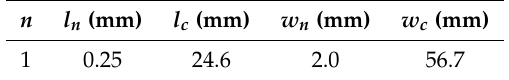
Table A1. Geometrical parameters for the resonator used in sample N = 1.